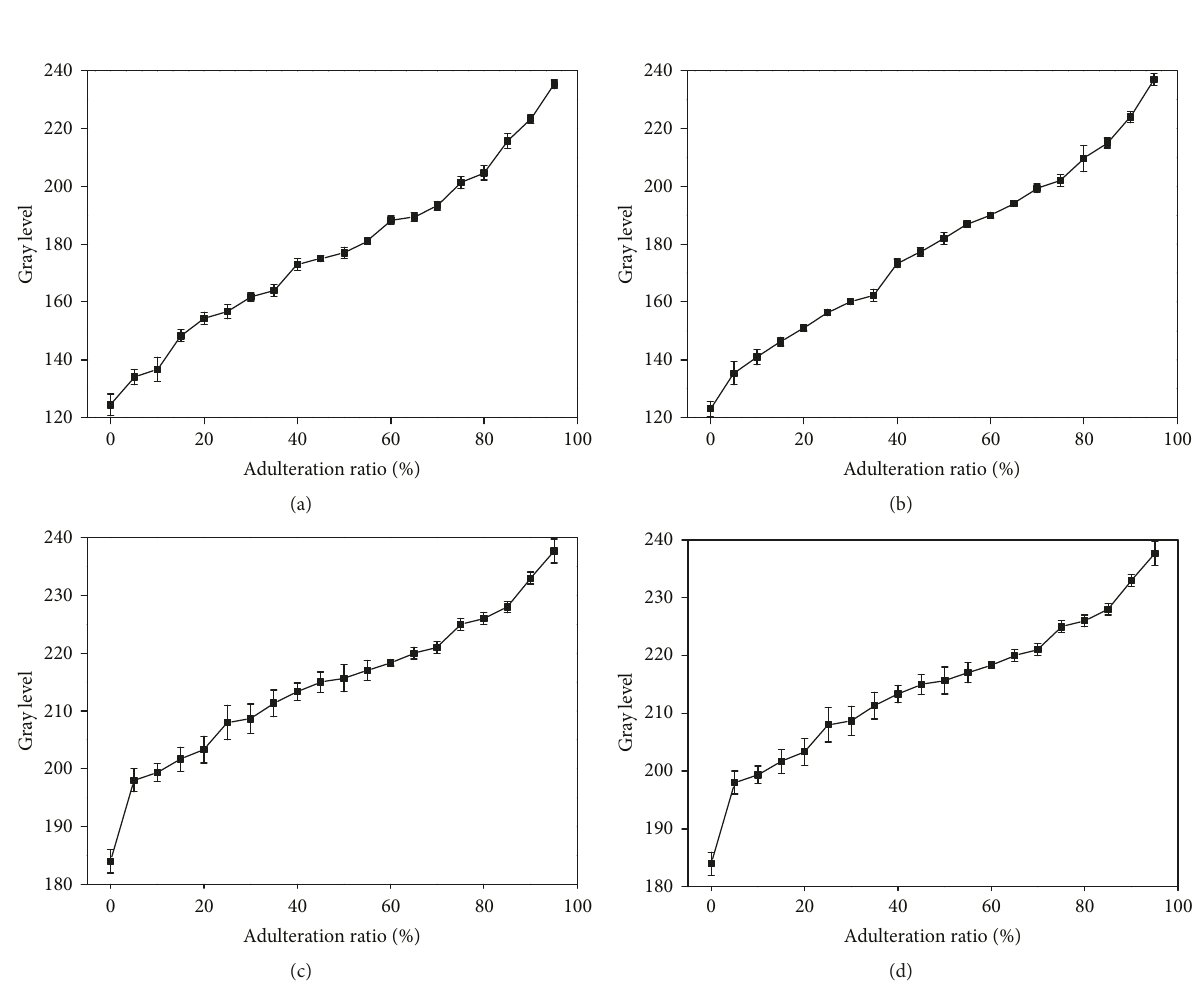
Figure 6: AGL of samples adulterated with PSG in the range of 0–95% corresponding to the first CW of 695 nm (a), 694 nm (b), 934 nm (c), and 934 nm (d) for different preprocessing (no preprocessing, MSC, SG, and